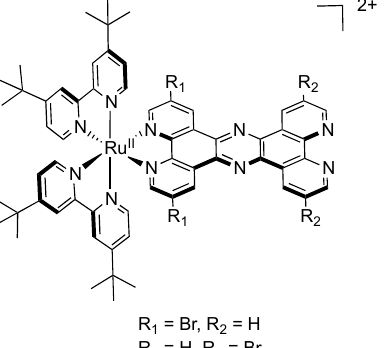
3. Half-wave potentials E[V] vs. Fc/Fc + in acetonitrile with 0.1M